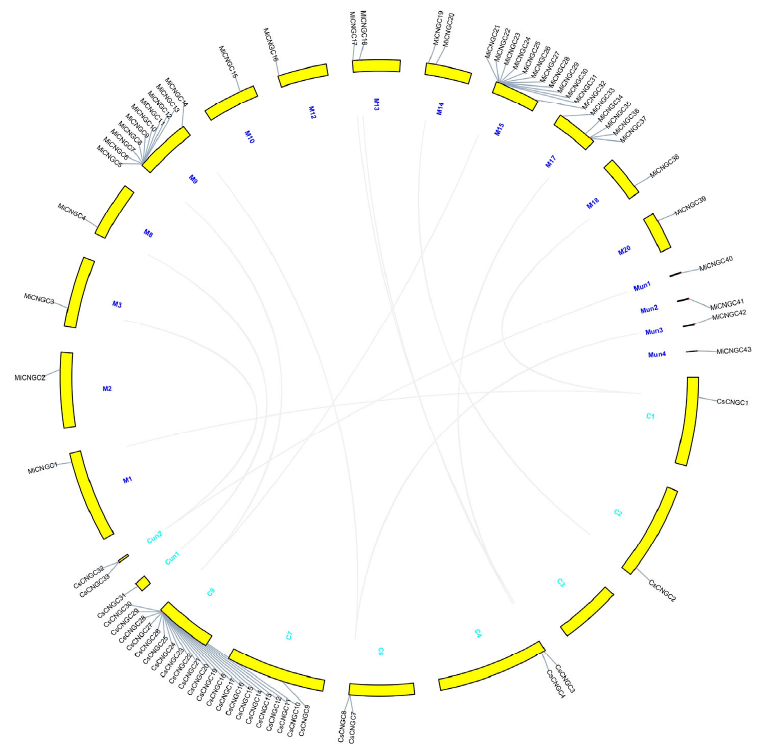
Figure 1. Chromosome distribution of CNGC genes in mango (blue) and sweet orange (light blue). The chromosome numbers are marked with numbers beside the chromosomes. Homologous gene pairs between the two species are linked with lines. The ‘un’ represents unanchored scaffolds.